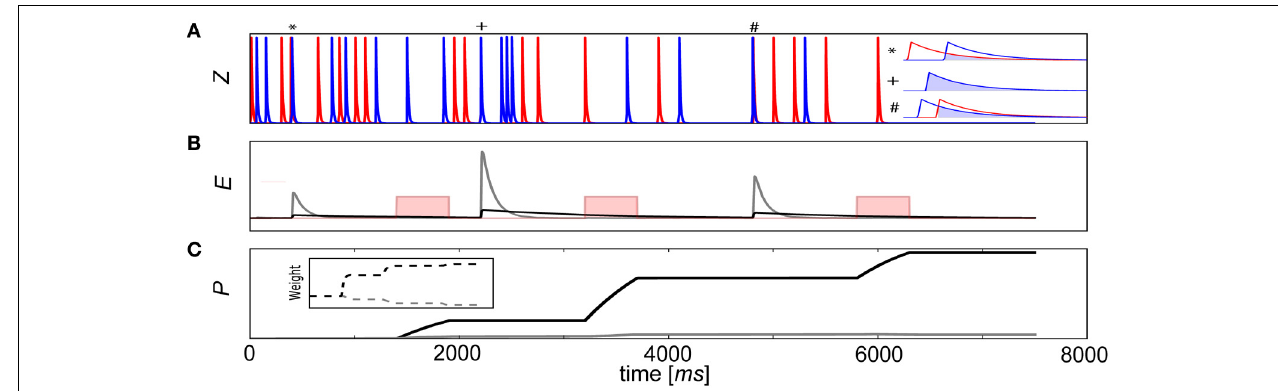
FIGURE 3 | Delayed reward learning using E traces. (A) A pair of neurons fire randomly and elicit changes in the pre- (red) and postsynaptic (blue) Z traces of a BCPNN synapse connecting them. Sometimes by chance (pre before post ∗ , synchronous + , post before pre # ), the neurons fire coincidentally and the degree of overlap of their Z traces (inset, light blue), regardless of their order of firing, is